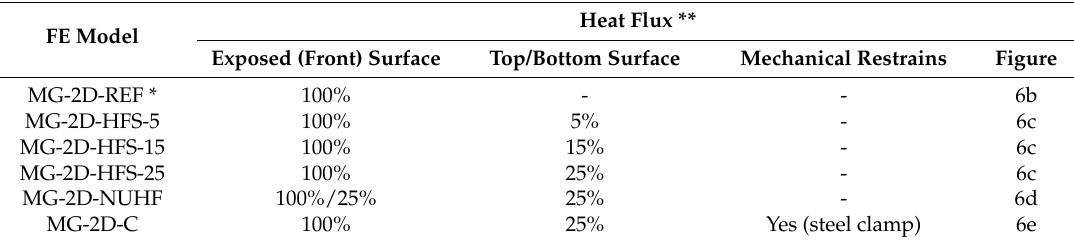
Table 3. Input properties for the 2D parametric models (ABAQUS). Heat Flux ** FE Model Exposed (Front) Surface Top/Bottom Surface Mechanical Restrains Figure - -